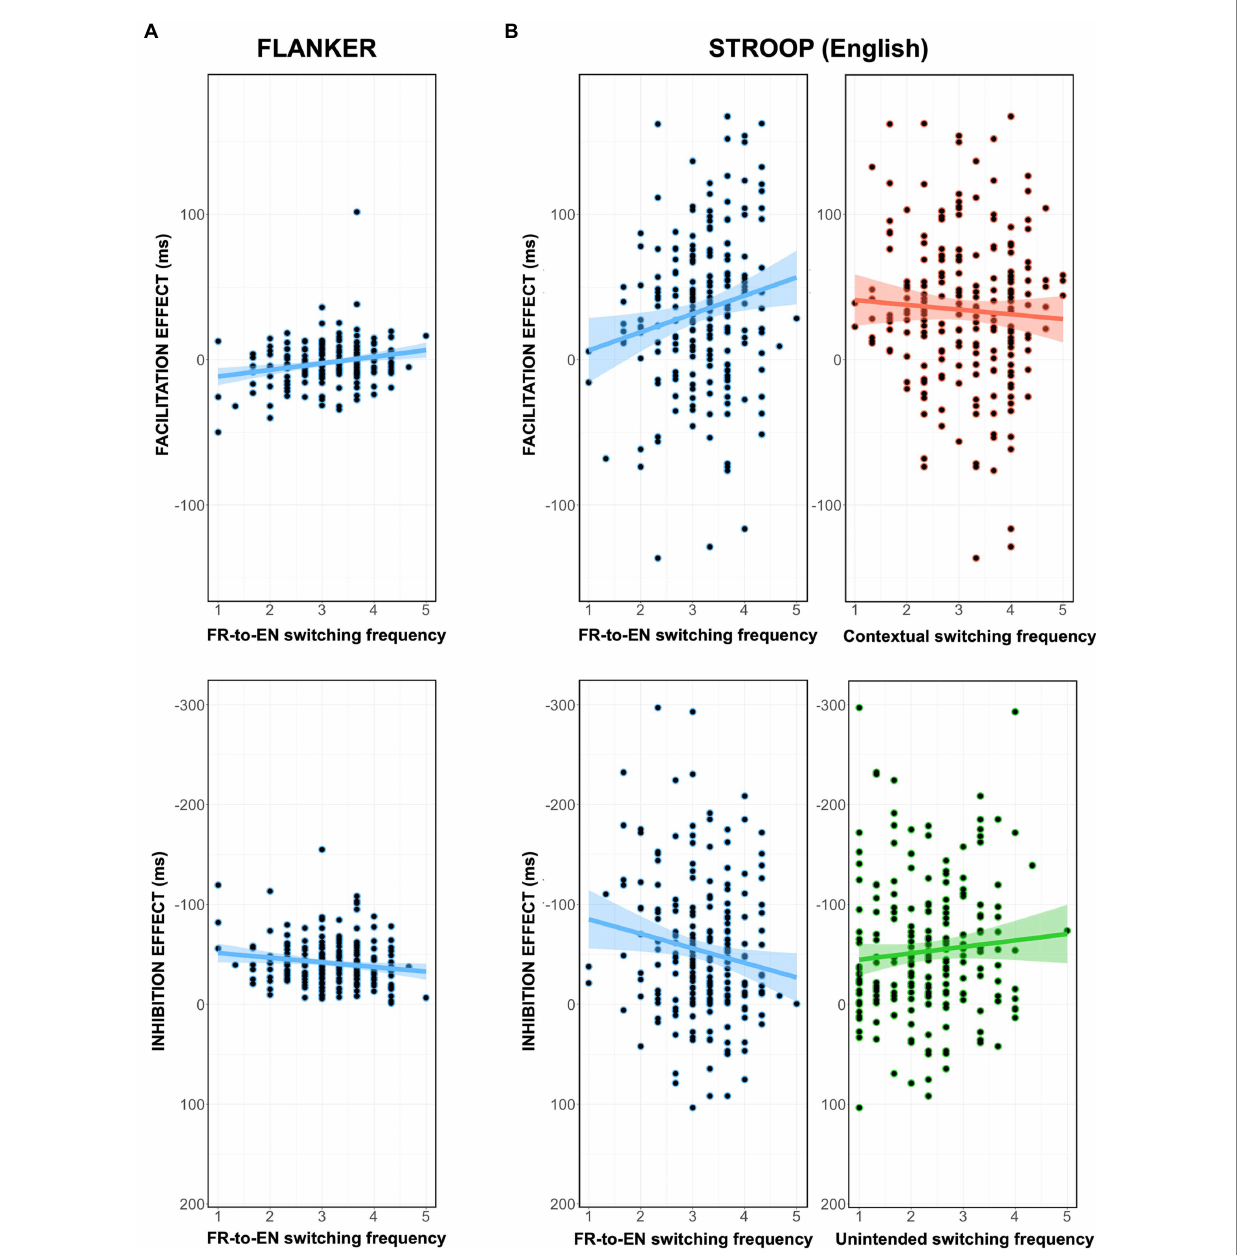
FIGURE 4 (A) Visualization of the significant predictor for the Flanker facilitation effect (top) and inhibition effect (bottom). (B) Visualization of the significant predictors for the Stroop facilitation effect (top) and inhibition effect (bottom). The shaded areas surrounding the regression line represent the standard error of the regression. Note that for inhibition effects, negative is plotted